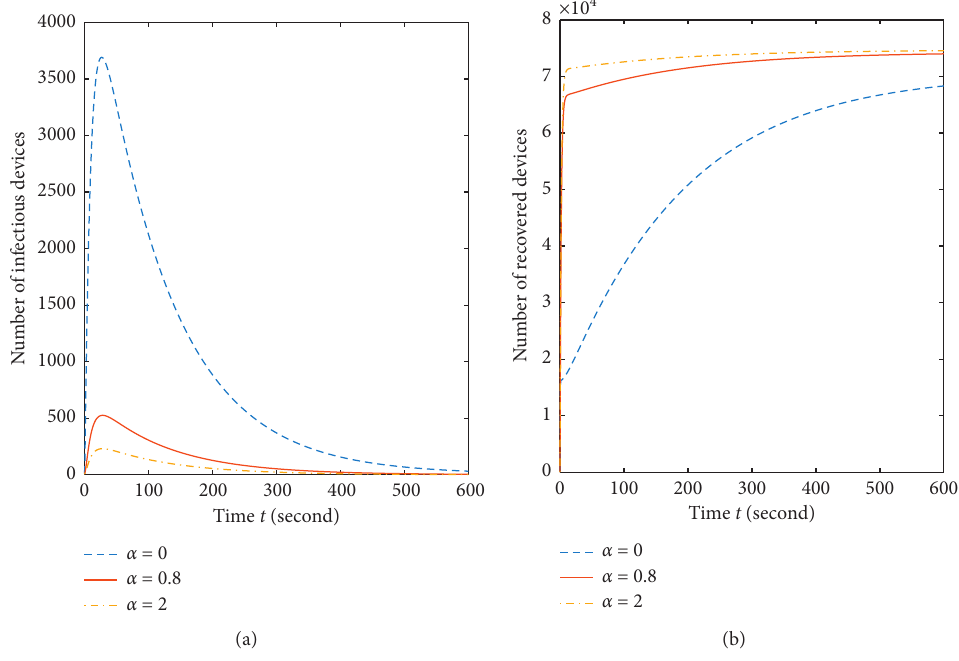
Figure 2: Sensitivity analysis of parameter in saturated incidence